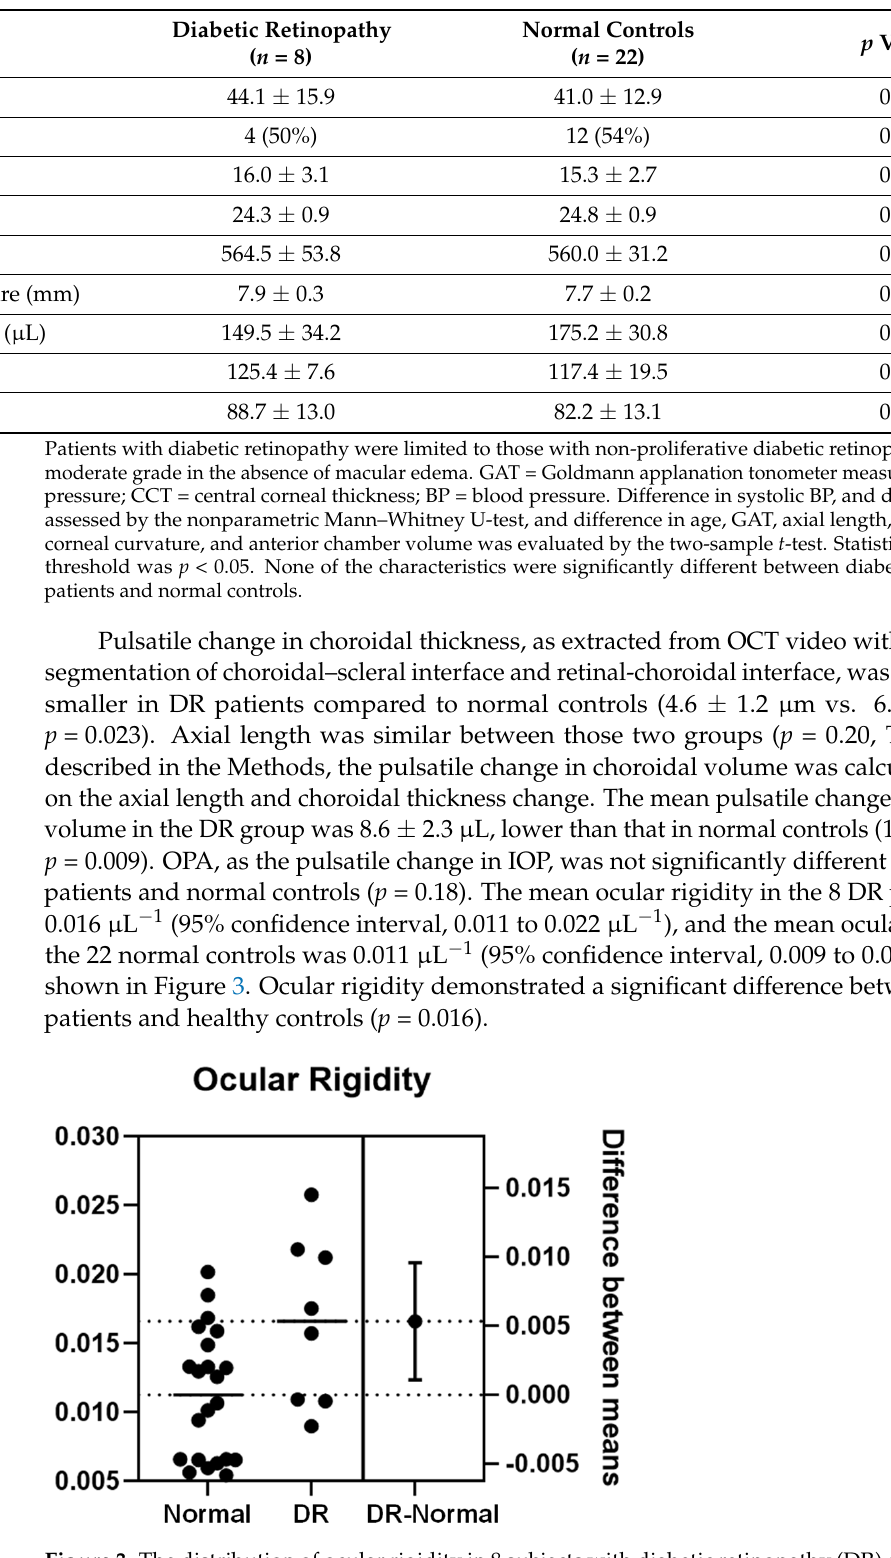
Figure 3. The distribution of ocular rigidity in 8 subjects with diabetic retinopathy (DR) and 22 healthy controls. DR patients show a higher ocular rigidity than normal controls. The mean difference between these two groups is about 0.005 µ L − 1 (95% confidence interval, 0.0011 to 0.0096 µ L − 1 , as indicated by the error bar).